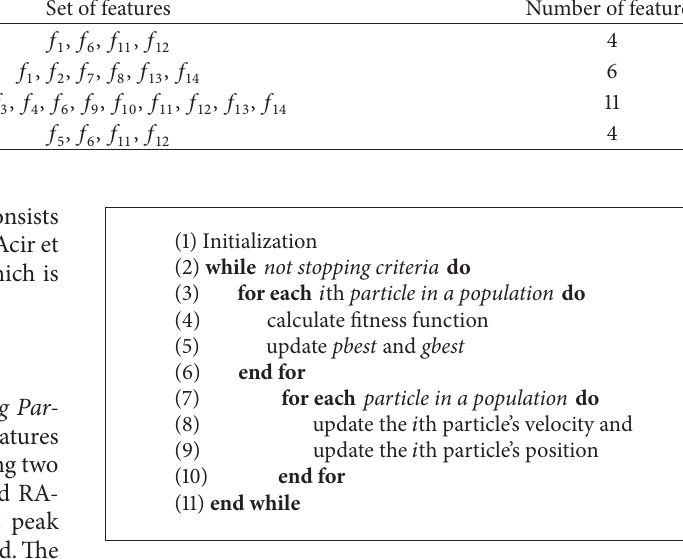
Algorithm 1: Standard PSO